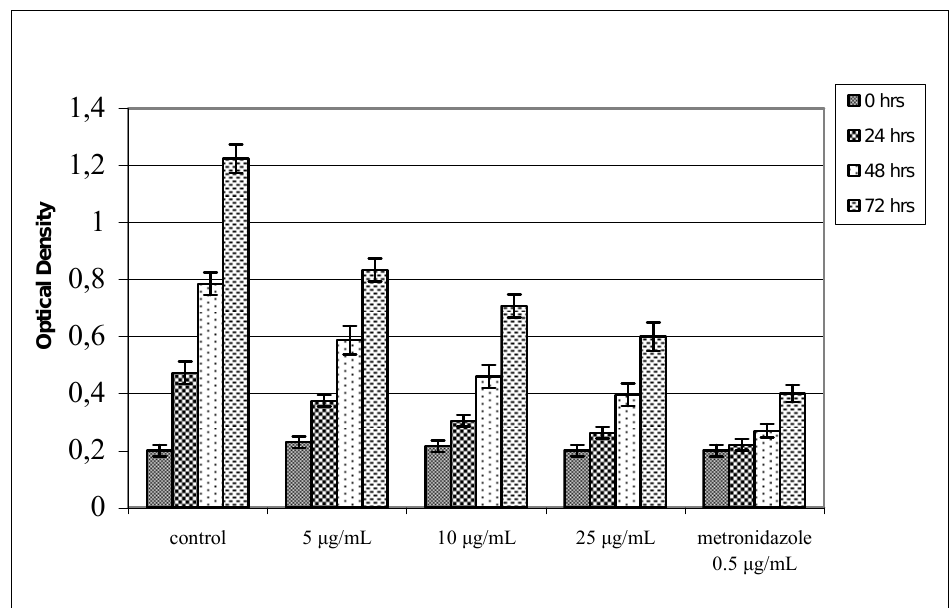
Figure 4 . Antibacterial activity of agasyllin ( 3 ) against H. pylori growth expressed as O.D. at 450 nm. Control cultures were made culturing the bacterium without and with